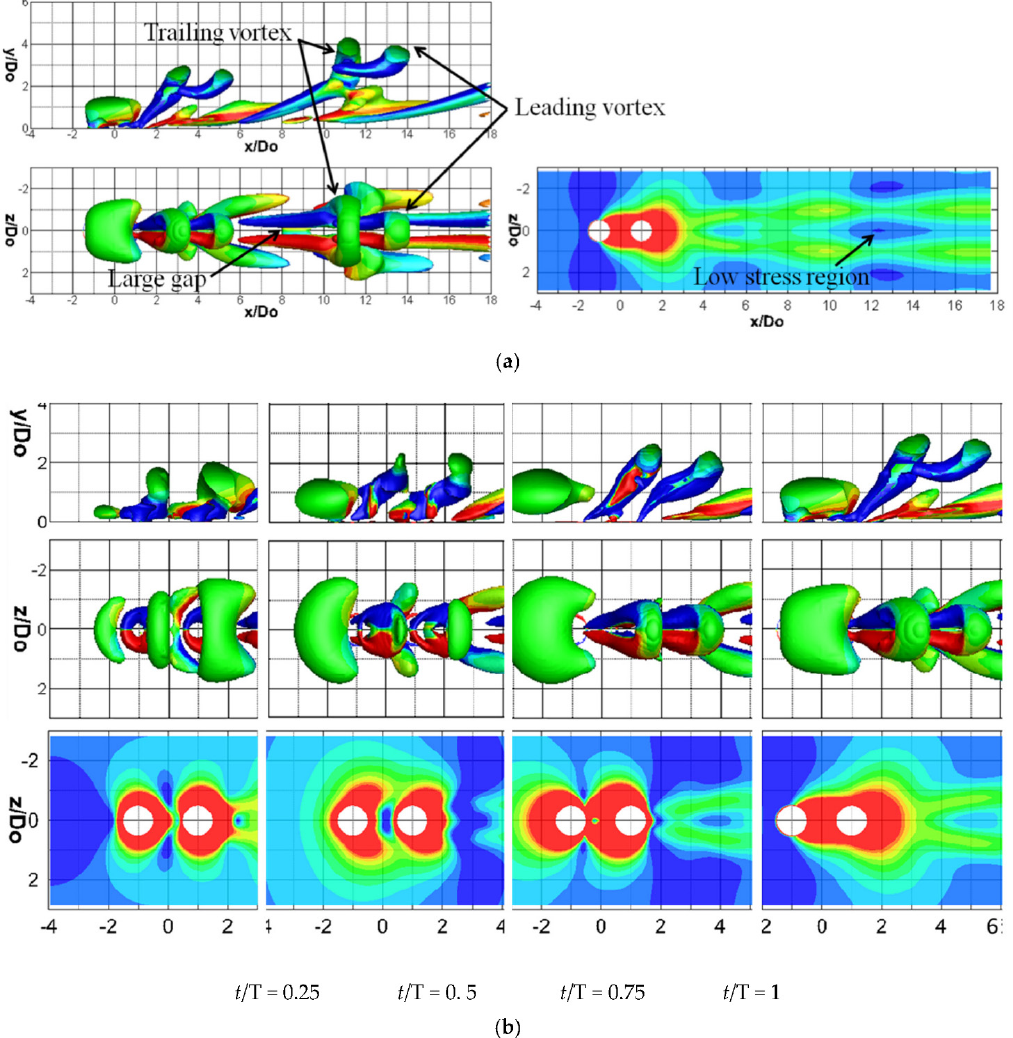
Figure 14. Vortex structures and excess wall shear stress for the twin SJs operating with ∆ φ = 0. ( a ) Vortex structures ( left ) and excess wall shear stress ( right ) at t /T = 0. ( b ) Evolution of vortices ( upper two rows) and corresponding excess wall shear stress ( bottom row). The color map can be referred to Figure